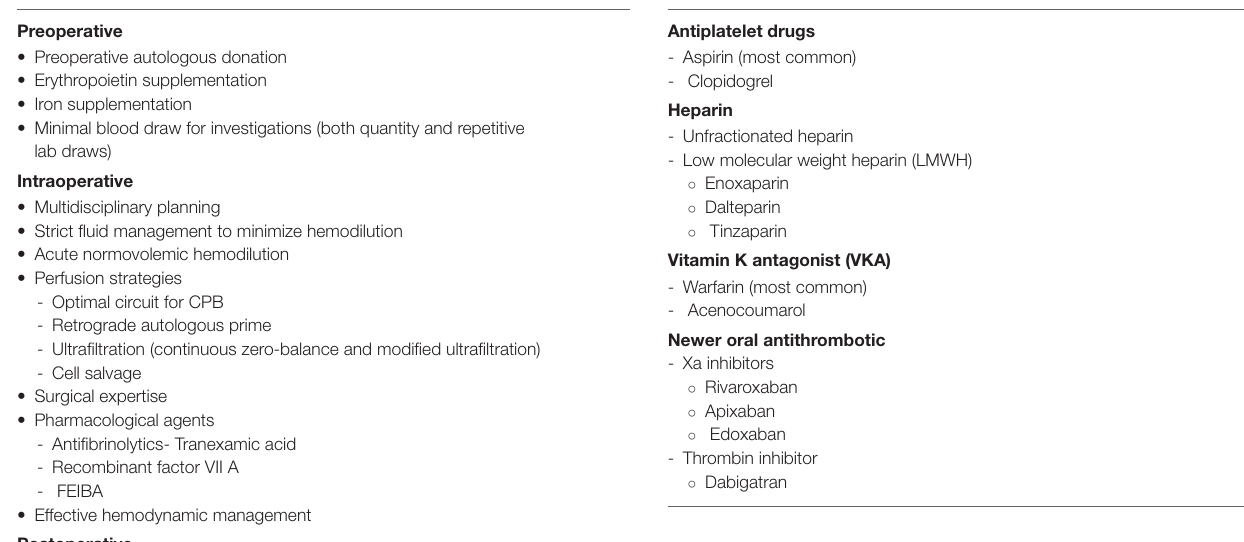
TABLE 3 | Perioperative blood conservation strategies. TABLE 4 | Antithrombotic